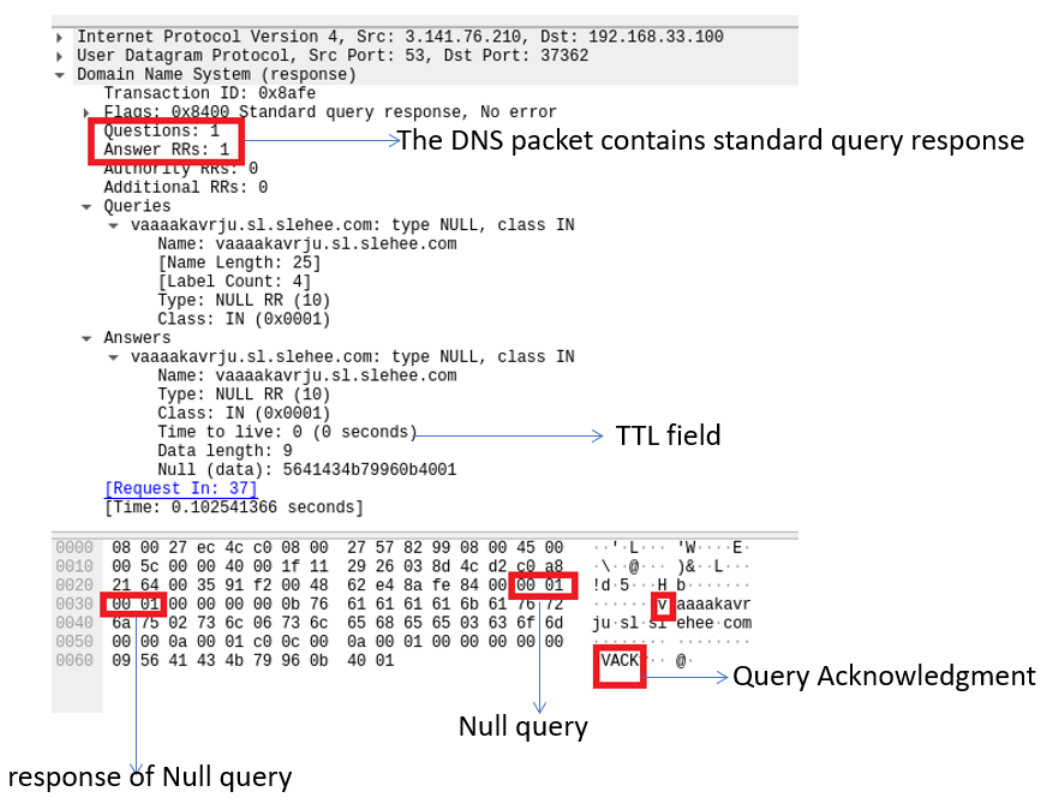
Figure 12. Handshake (ACK) between Iodine DNS tunnelling server (attacker) and the victim. Analysis via Wireshark shows the DNS response packet from Null record exported and saved as a binary. The figure also shows the TTL field in the DNS query response.